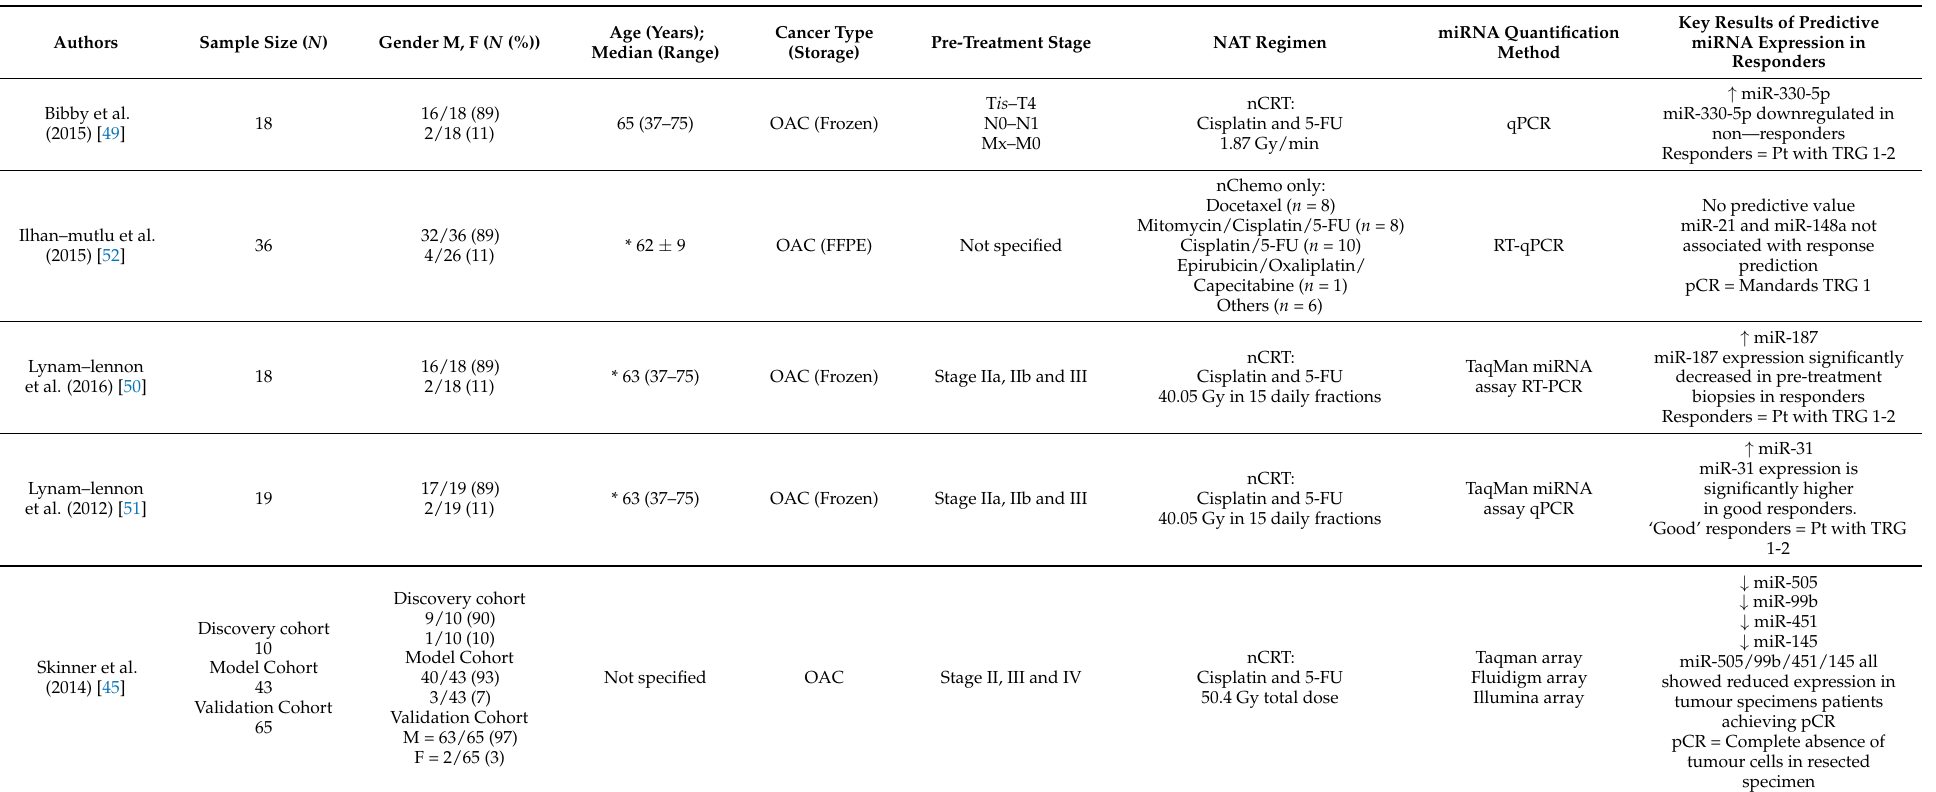
Table 1. Articles studying the utility of miRNAs in pre-treatment OAC samples to predict response to